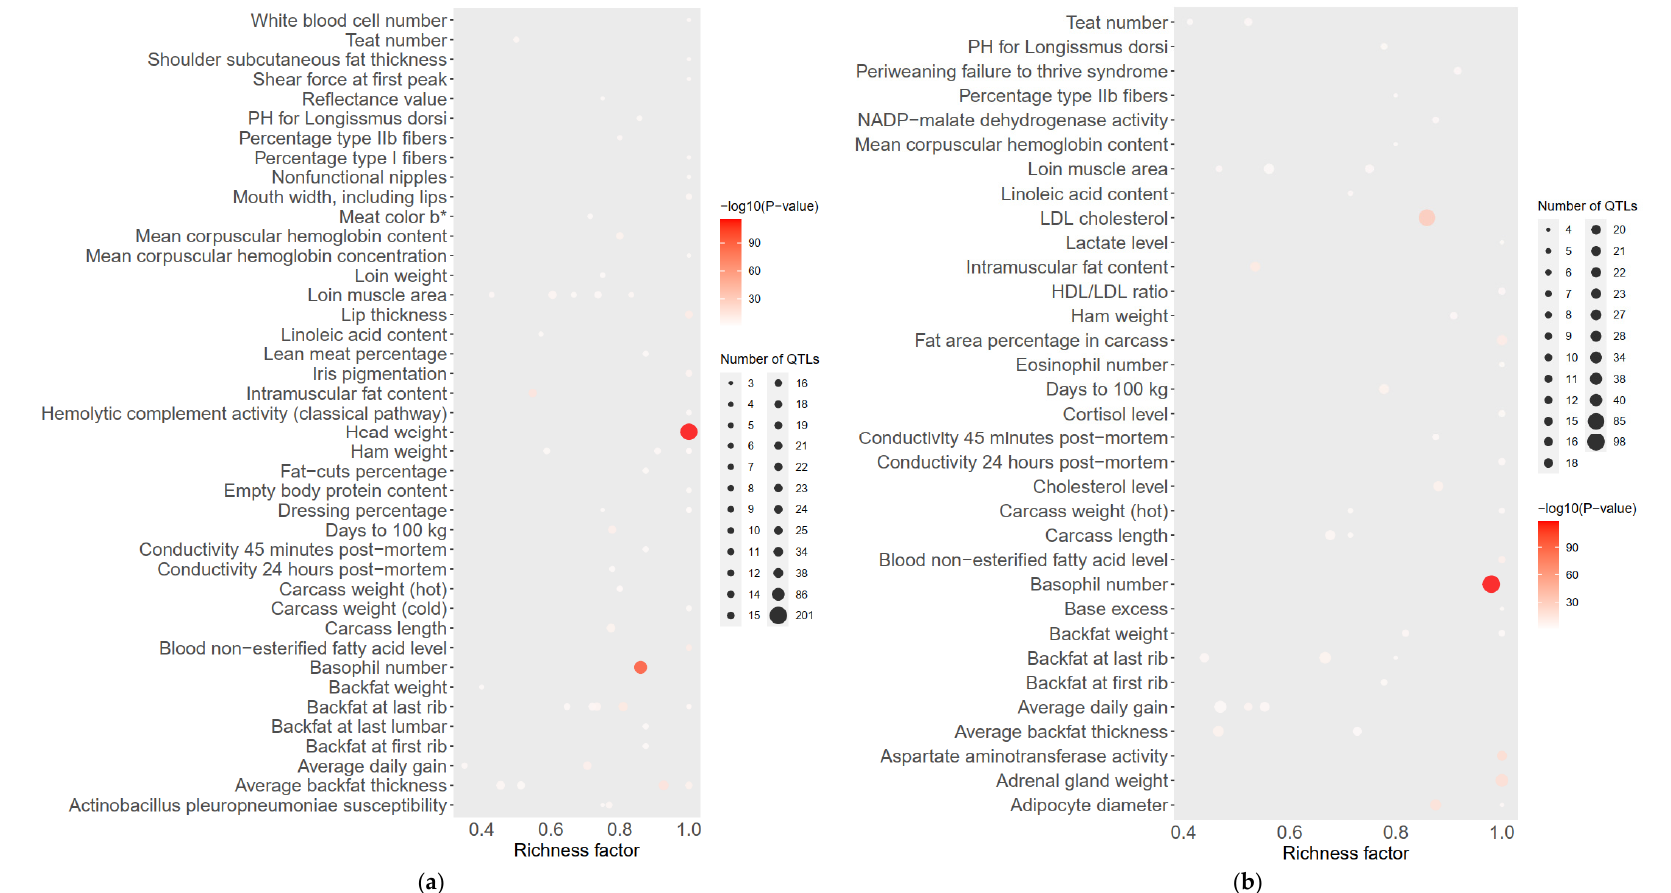
Figure 6. ( a,b ) Bubble plot based on F st of LU–LW pigs and LU–YY pigs by GGRS to exhibit QTL enrichment results. The significant phenotype of LU–LW is head weight and the significant phenotype of LU–YY is basophil number.